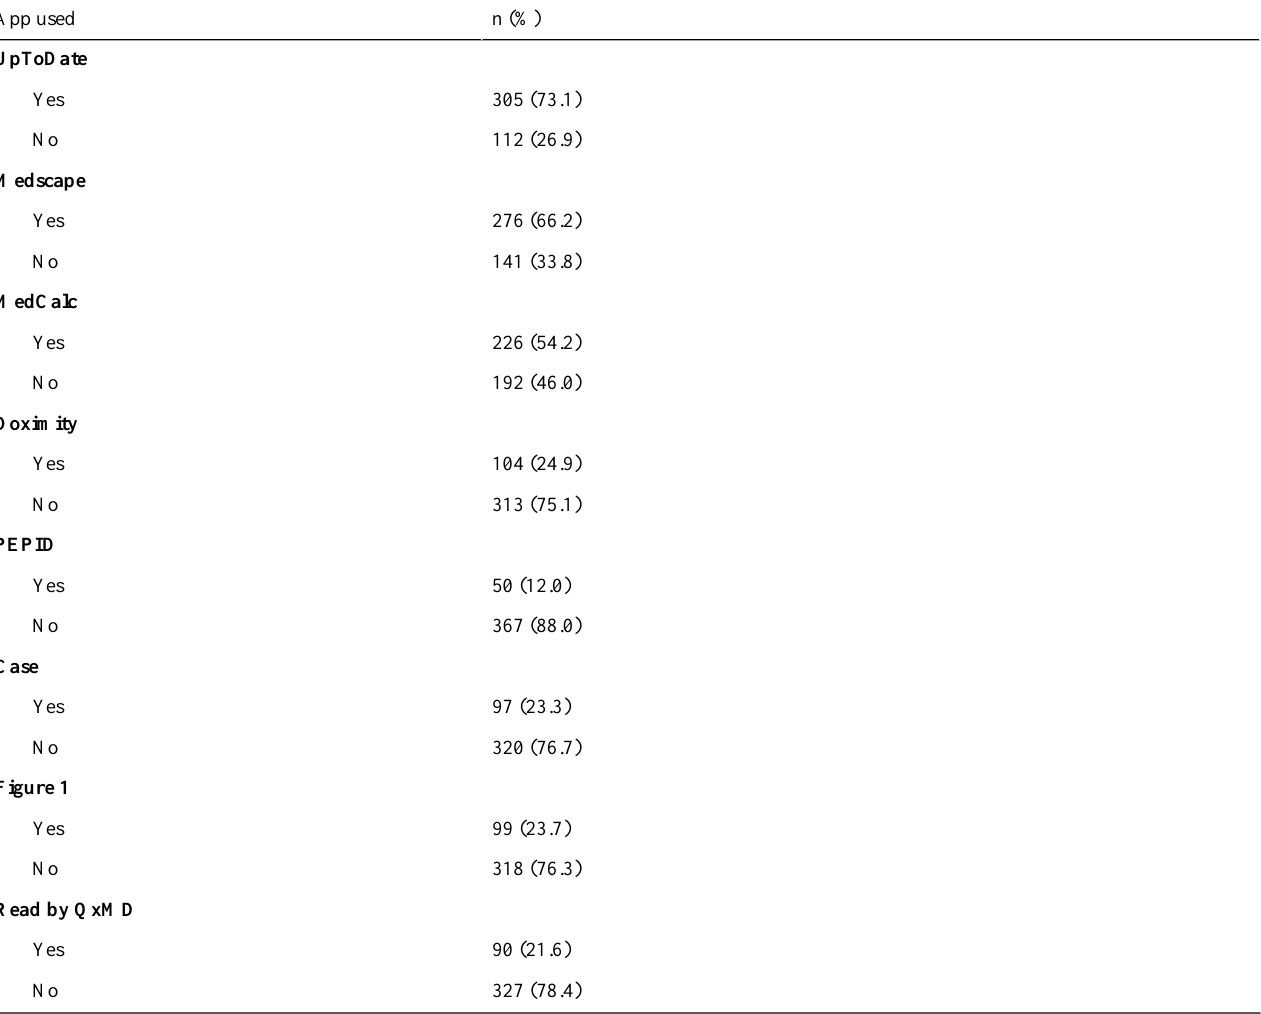
Table 4. Medical apps used by physicians working at referral hospitals in Amhara regional state, Ethiopia, 2019.